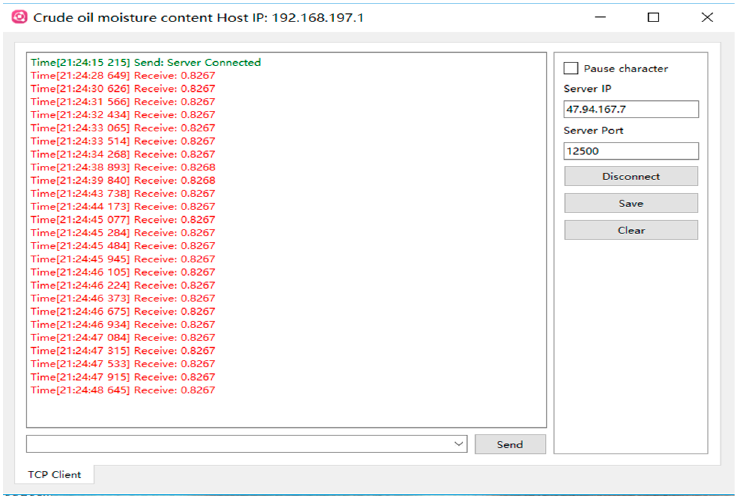
Figure 12. The interface of the PC monitor software.